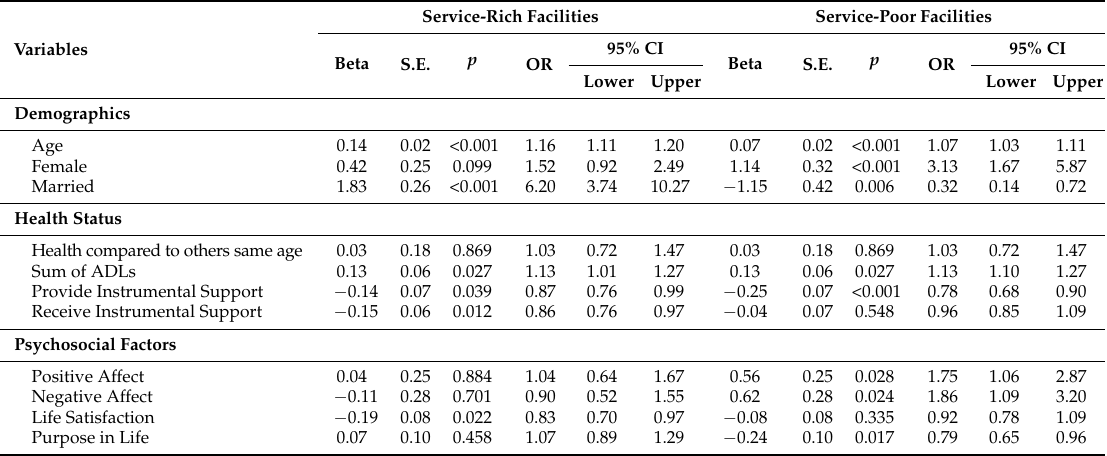
Table 2. Multinomial logistic regression examining factors associated with housing types.